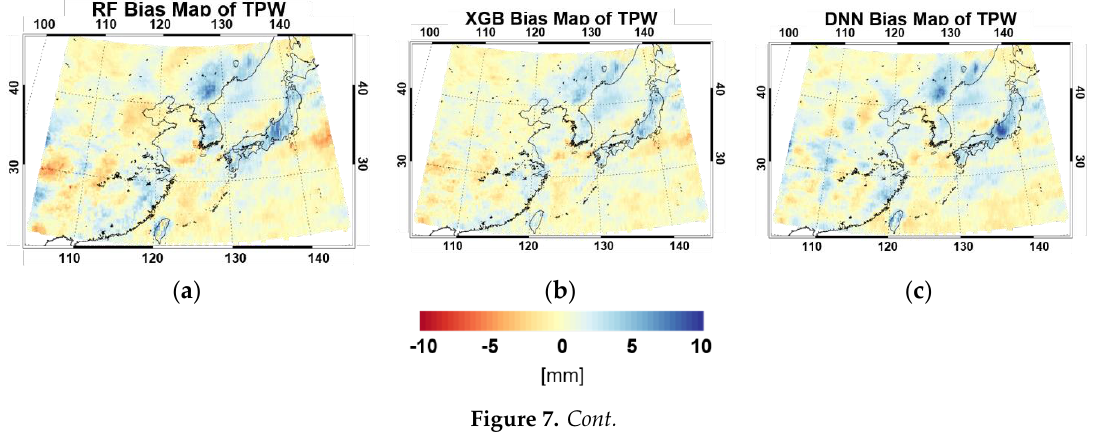
Table 5. Accuracy assessment based on ERA-Interim TPW for the RF, XGB, and DNN in Northeast Asia (1 st , 25 th per month from September 2016 to August 2018). Validation metrics (i.e., bias and RMSE) are calculated over the ‘all’, ‘land’, ‘sea’, and ‘coast’ regions, respectively. all land sea coast